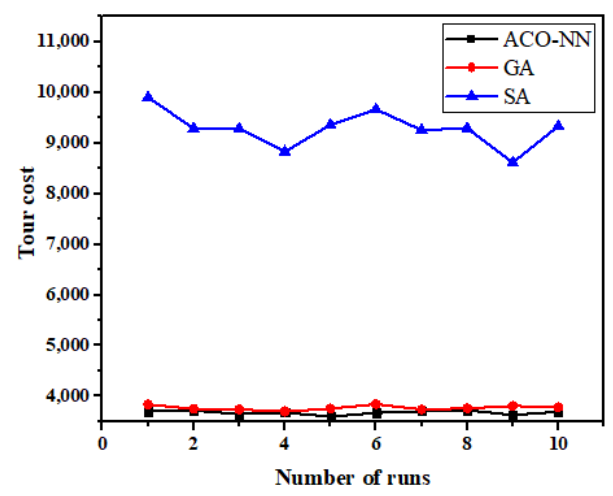
Figure 6. Comparison of ACO-NN to GA and SA for